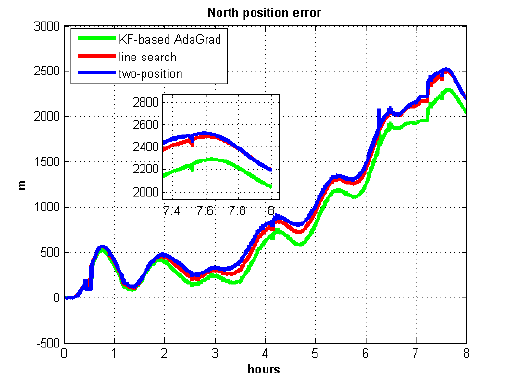
Figure 26. North position error in test 3.